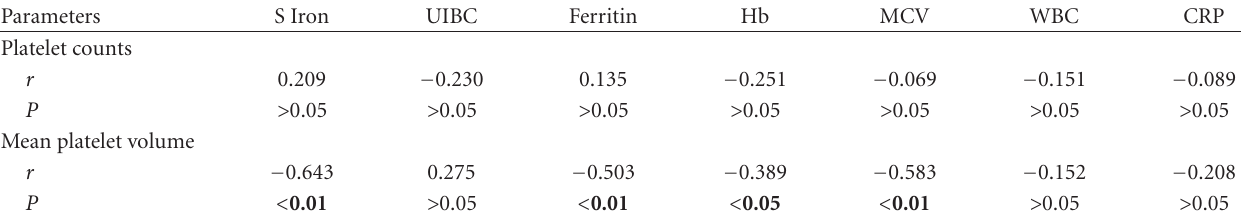
Table 5: The results of Pearson’s correlation test in patients with reactive thrombocytosis (iron deficiency